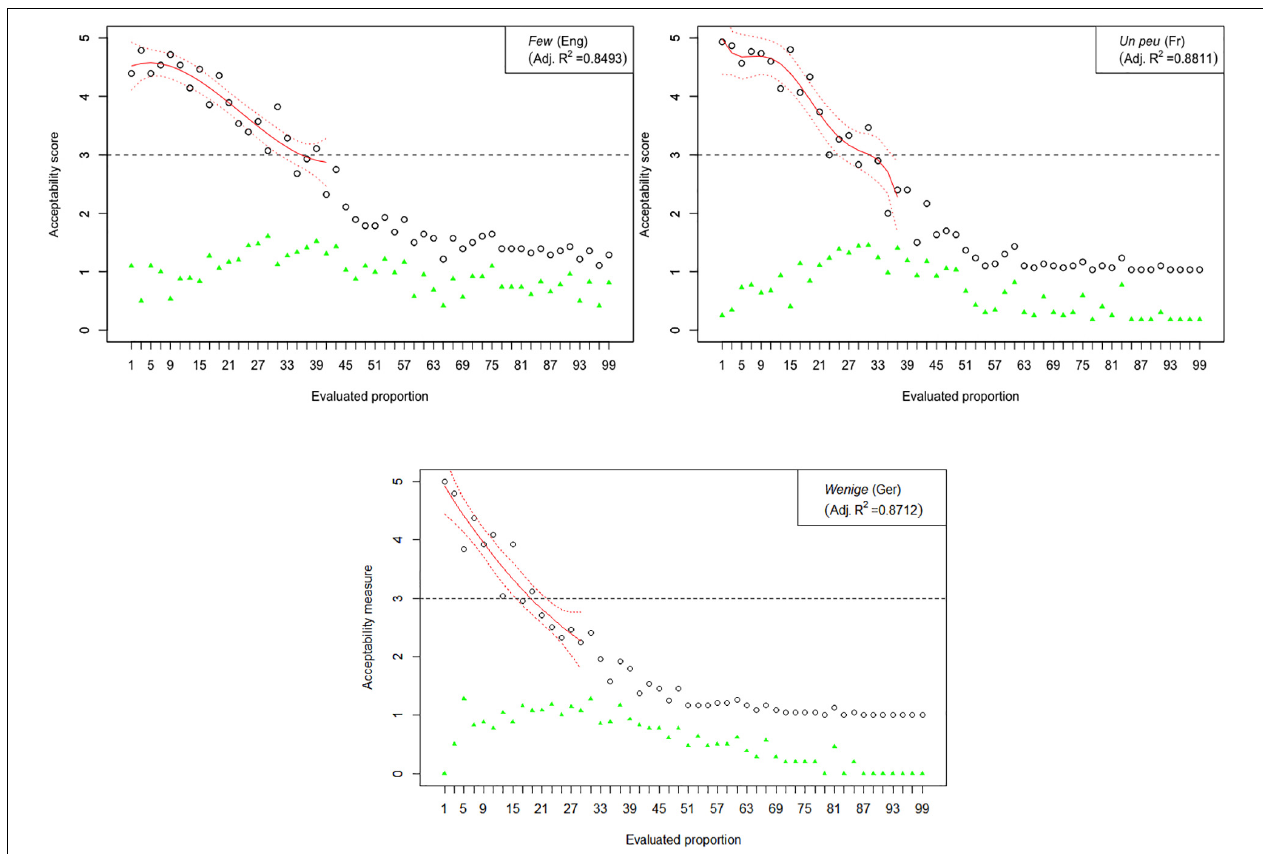
FIGURE 2 | Experiment 1: Mean acceptability scores on few and its cross-linguistic variants in the three tested languages (absolute values of standard deviation for respective means are shown in green), together with respective polynomial fit curves and confidence intervals (in red) predicting acceptability in the upper half of the Likert